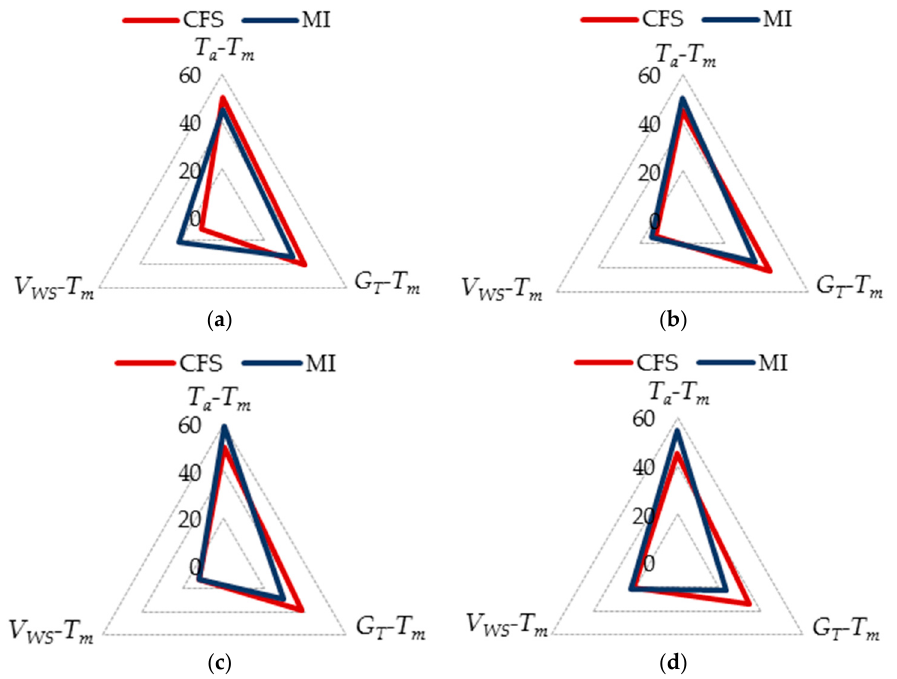
Figure 10. Relevancy between MIFs and PV module temperature measured by correlation-based